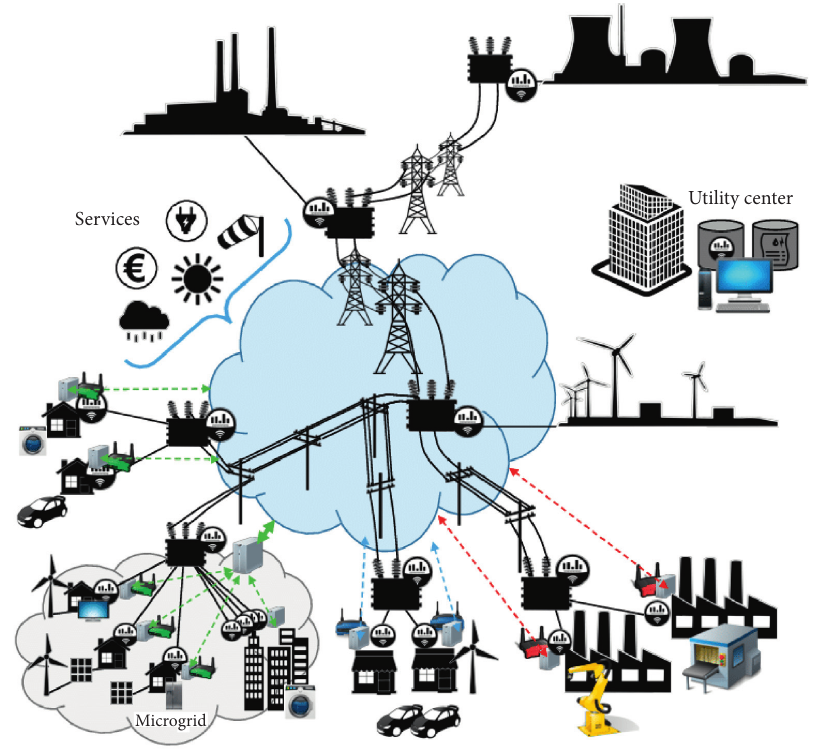
Figure 2: Energy penetration from numerous sources including microgrids with clean energy integration to the power